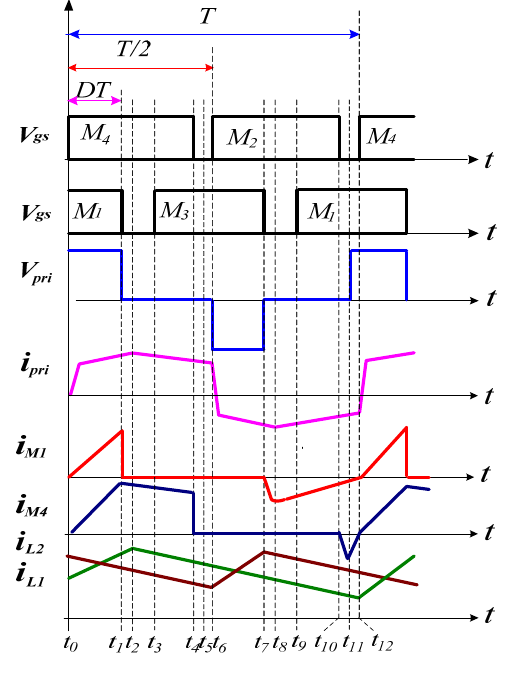
Figure 6. Driving signals of switches ( M waveforms of key components for charging